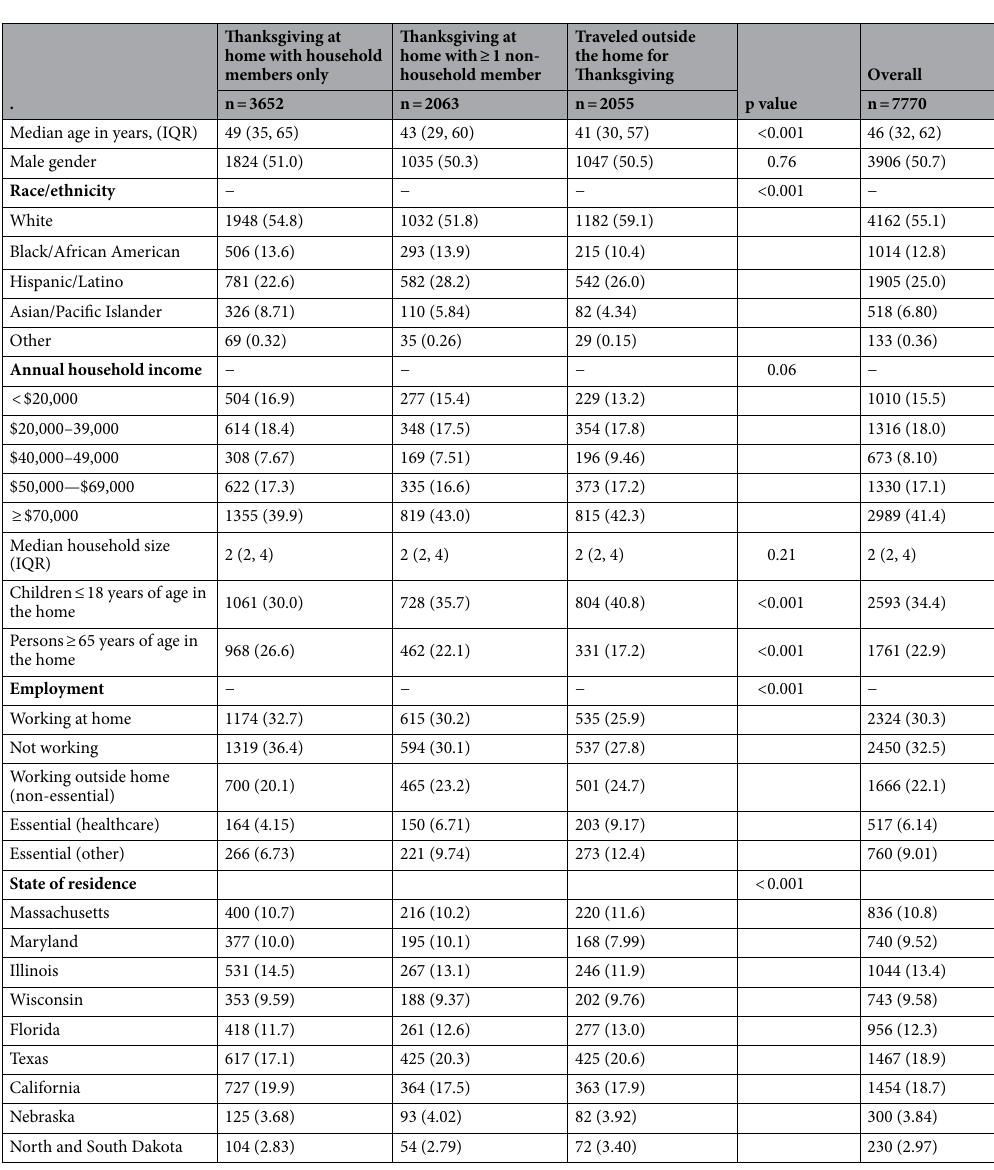
to total if there were participants who elected not to answer a given question. P values from Kruskal–Wallis tests for continuous variables and chi-squared tests for categorical variables using unweighted estimates. IQR, interquartile